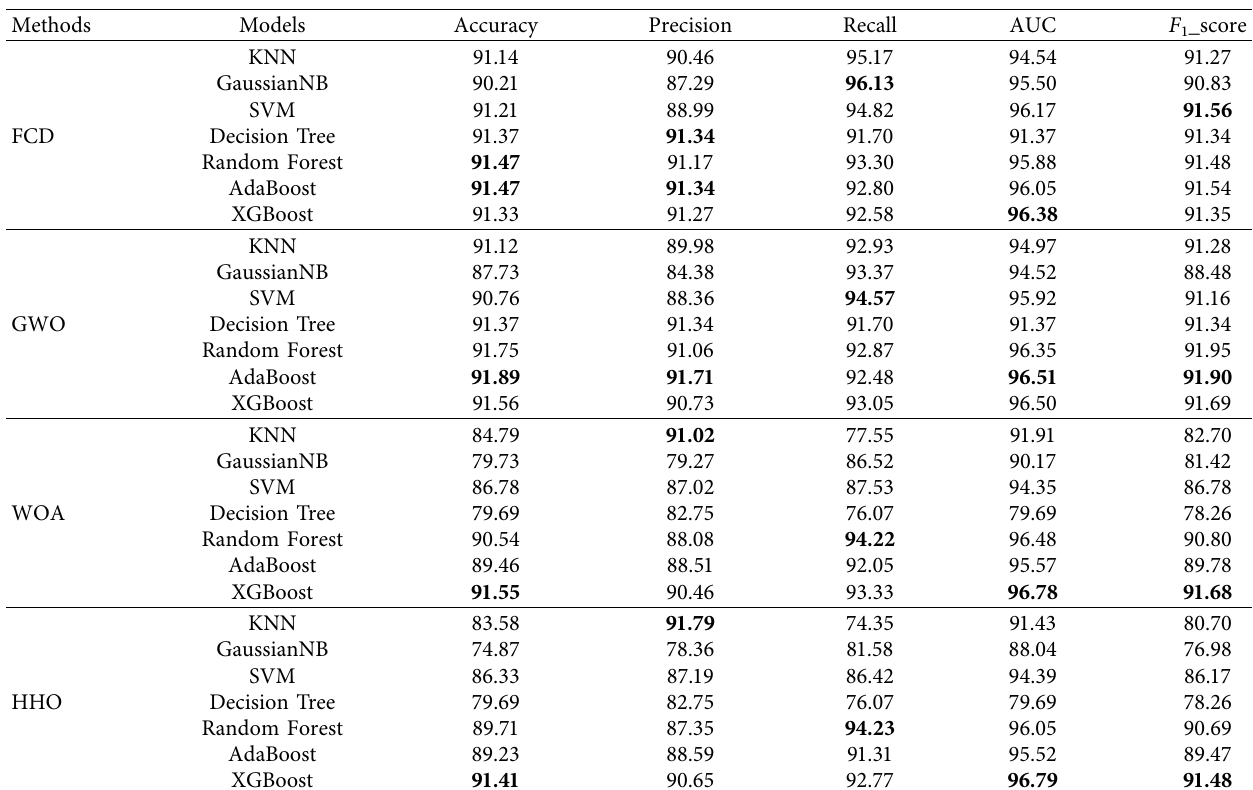
The bold values represent the maximum value in each column of evaluation indicators under each feature selection